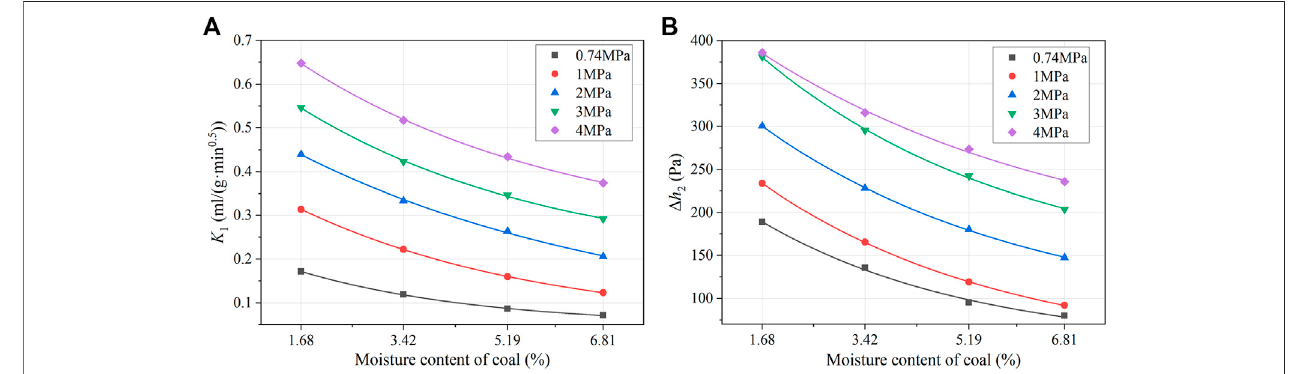
FIGURE 10 | Effect of different moisture content of coal on K 1 and Δ h 2 . (A) Effect on K 1 . (B) Effect on Δ h 2 .